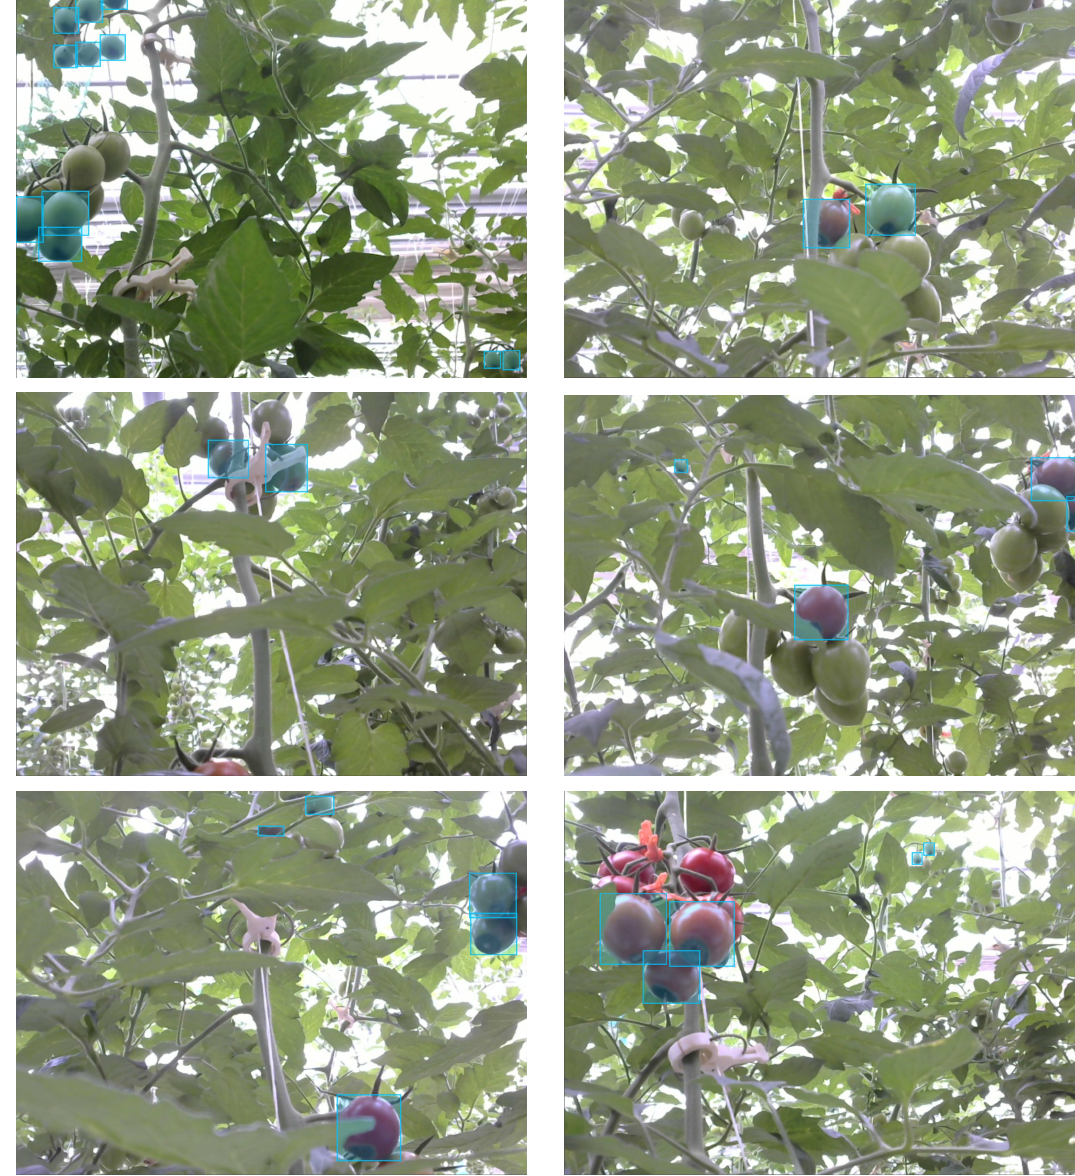
Figure 11. Examples of labeled tomatoes with BER. Regardless of size or cover, all tomatoes with BER are